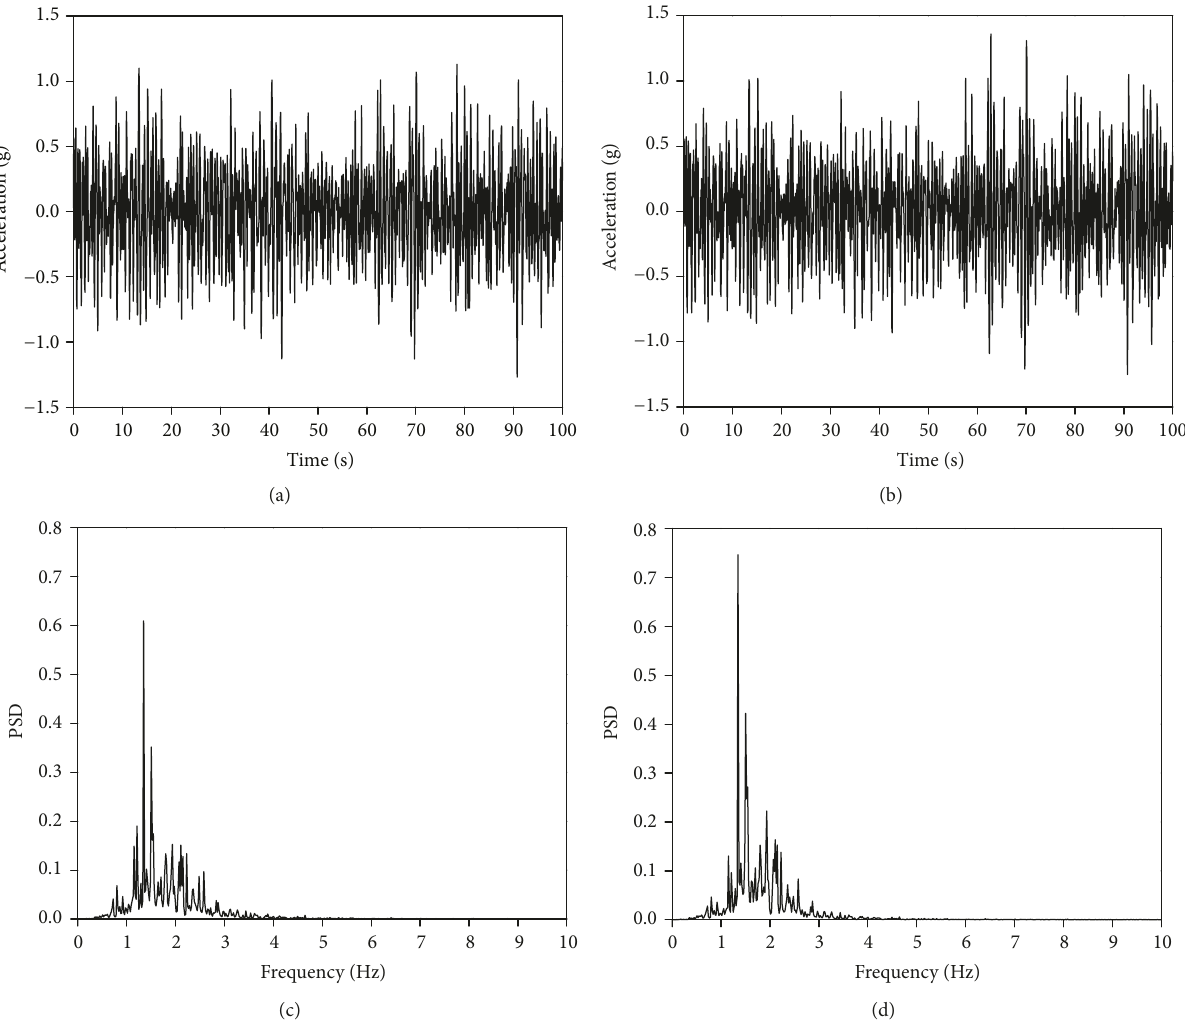
Figure 13: Acceleration results under 0 ∘ wind direction: (a) 𝑋 acceleration of point 1; (b) 𝑌 acceleration of point 3; (c) power spectral density of point 1; (d) power spectral density of point